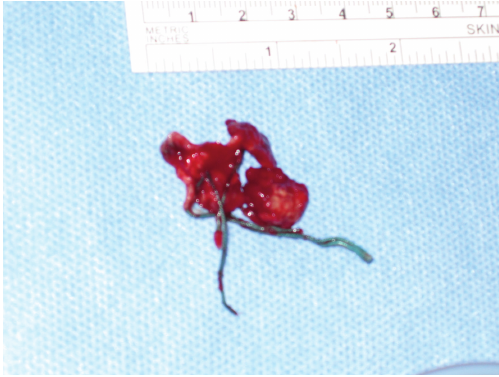
Figure 3: Excised Ethibond suture as focus of